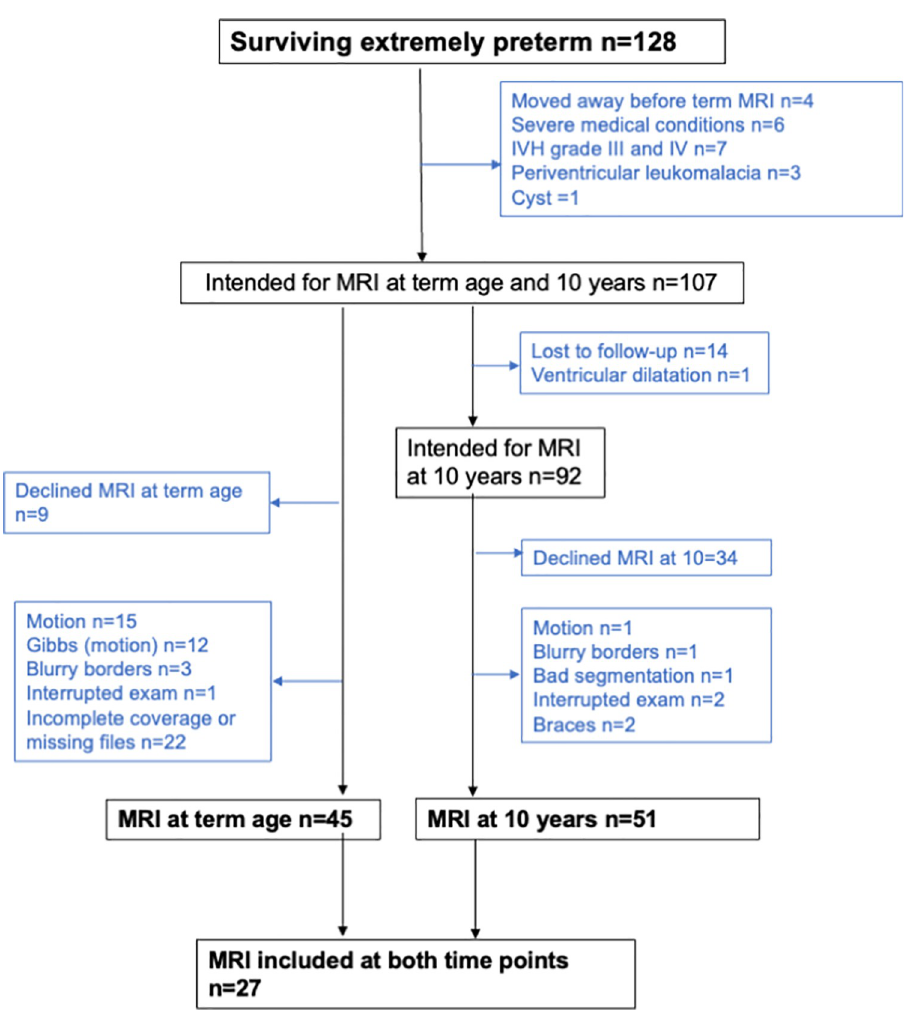
Fig 1. Flow chart for extremely preterm children. Extremely preterm children alive at birth, in Stockholm from January 1 2004 to March 31 2007 who underwent magnetic resonance imaging (MRI) scans at term age and at 10 years of